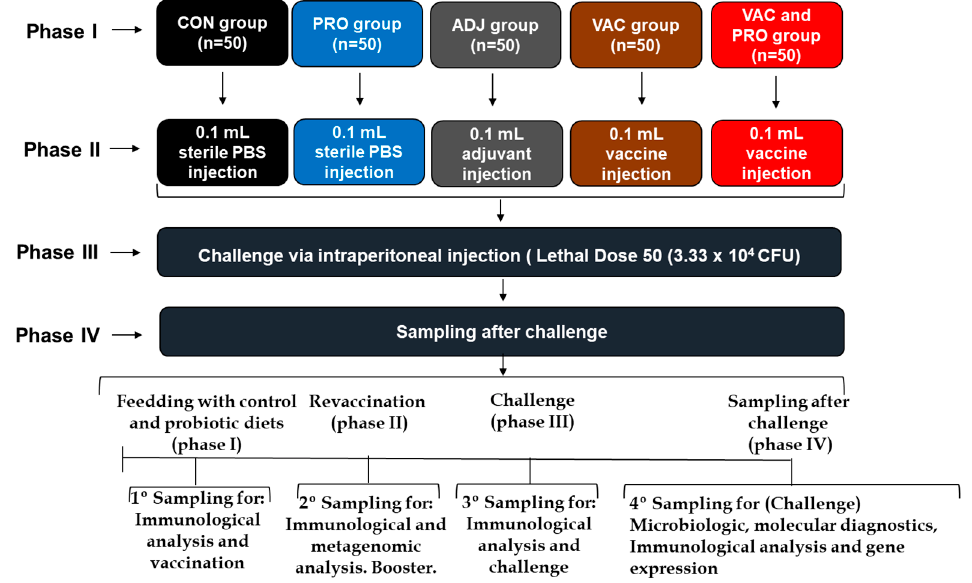
Figure 1. Experimental infection scheme of Nile tilapia, O. niloticus in vivo assay, fed with probiotic diets, vaccinated (two doses) and challenged against S. agalactiae serotype Ib. A total of 300 Nile tilapia (mean weight 20 g ± 2.07) were distributed into 25 aquaria of 50 L with water recirculating system, aeration and temperature control. The water parameters (dissolved oxygen level, temperature and pH) were measured by digital oximeter (Hanna ® instruments, São Paulo, Brazil), and ammonia and nitrite levels with specific kits (Labcon Test ® Alcon company, Santa Catarina, Brazil). The feces were removed three times per week, and photoperiod was adjusted to 12:12 h. The mean and standard deviation of the water quality parameters, for 63 days, were: dissolved oxygen 4.99 ± 0.10 mg. L − 1 ; pH 6.79 ± 0.20; total ammonia 0.27 ± 0.07 mg. L − 1 ; nitrite 0.40 ± 0.20 mg. L − 1 ; temperature 27.09 ± 0.10 °C.